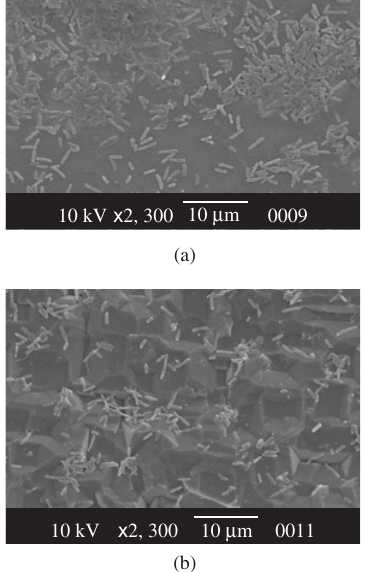
Figure 8. a) SEM microphotograph of Si smooth surface exposed during 2 hours to P fluorescens culture; and b) SEM microphotograph of Si rough surface exposed during 2 hours to P fluorescens. culture. Figure 6. Adhesion of streptococci consortia to rough Ti.